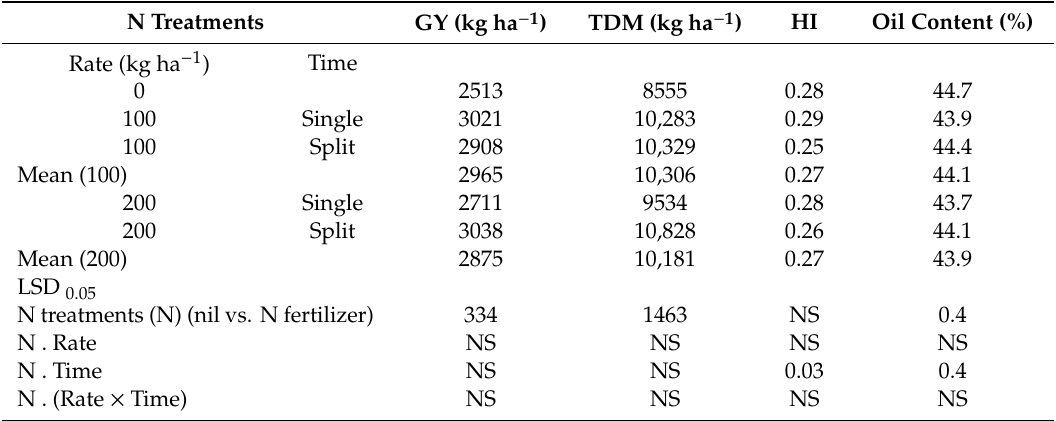
Table 3. E ff ect of di ff erent N applications on yield, total dry matter (TDM), HI and oil content of canola under rainfed conditions at Tarlee